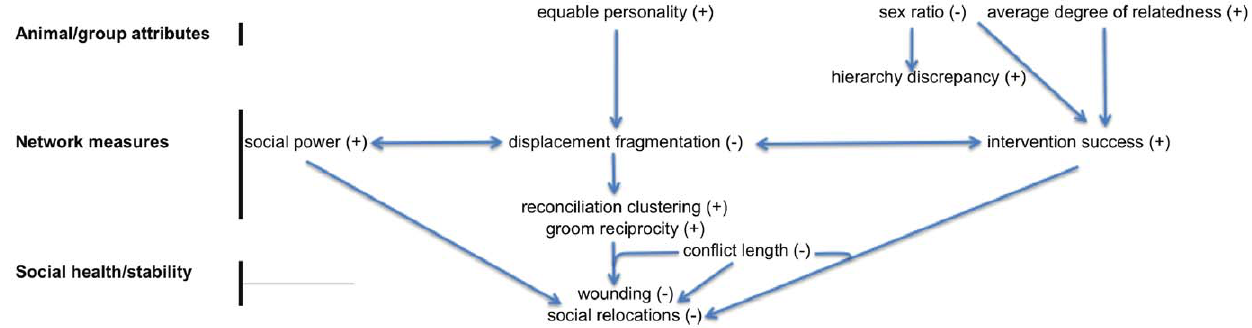
Figure 3. Schematic of the relationships found among animal/group attributes, network measures and social stability as measured by rates of wounding and social relocation. A ‘‘ + ’’ means that a positive value had the subsequent effect and a ‘‘-‘‘ means that a negative value has the subsequent effect. For example, a positive (higher) value of intervention success had negative effect (lowered rates) on wounding and social relocations. Conflict length was associated with multiple paths of social stability (see text).